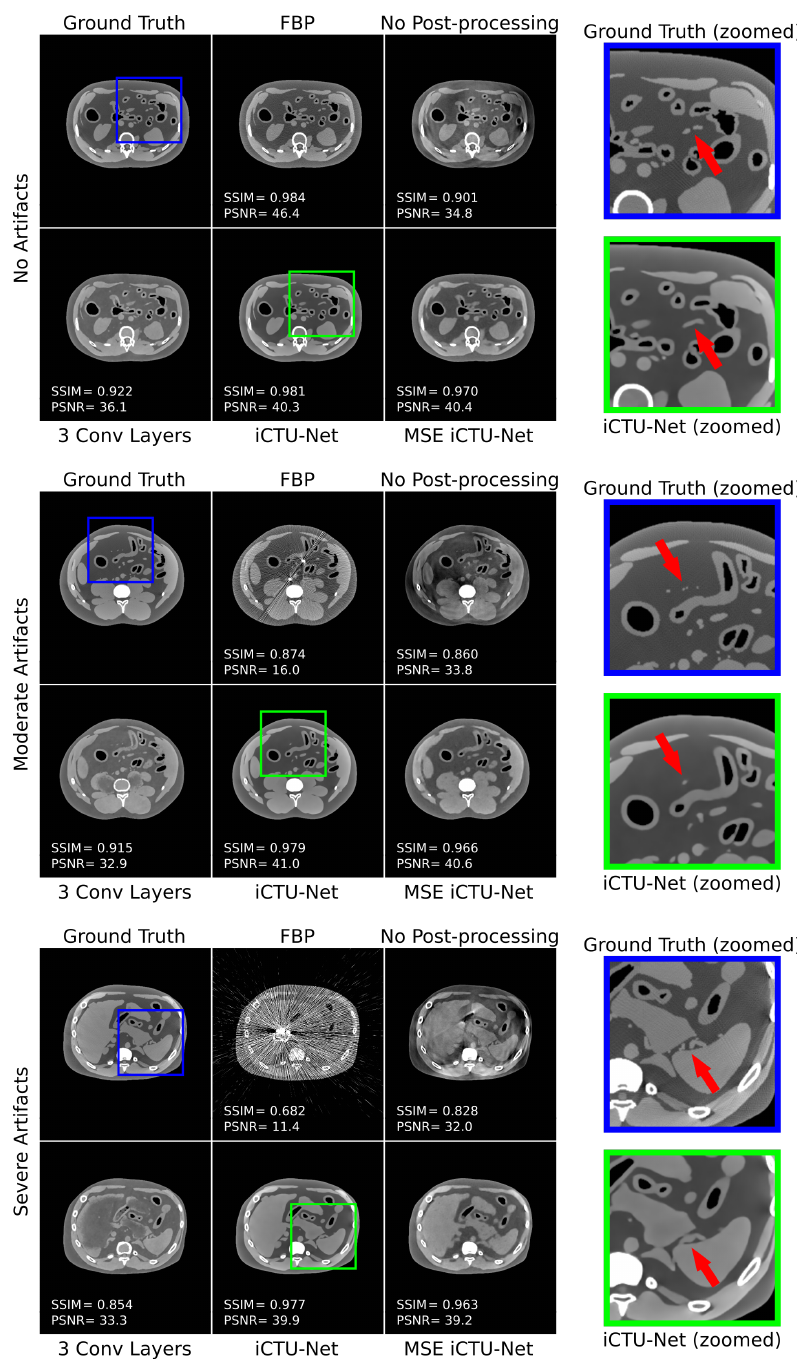
Figure 4. Results of the ablation study, where the ground truth and FBP are compared to different iCTU-Net settings. All networks are trained with pre-corrected NMAR sinograms and the SSIM loss, except for the MSE iCTU-Net, which is trained with the MSE loss. A slice without metal artifacts, with moderate metal artifacts, and with severe metal artifacts is shown. The scans are windowed to [ − 300 HU, 300 HU] to increase the visibility of the artifacts. The arrows in the zoomed regions indicate small structures that the iCTU-Net cannot resolve